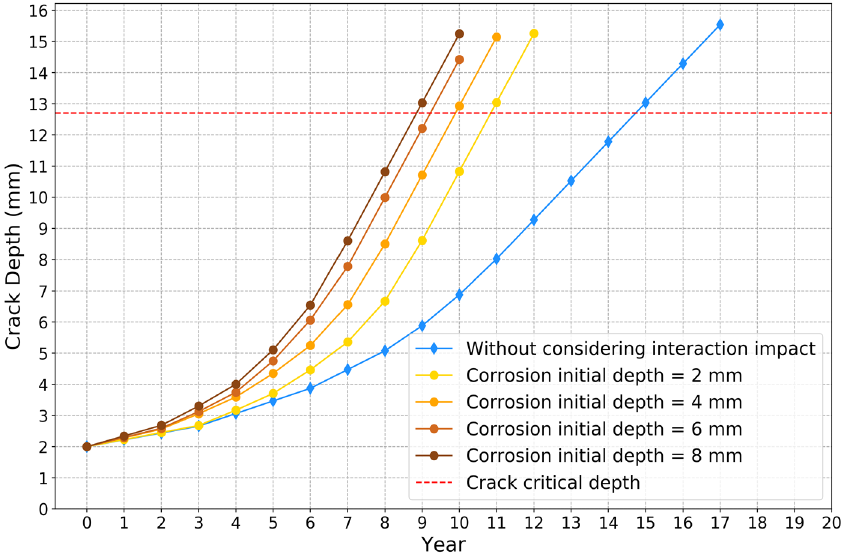
Figure 16. Crack depth growth curves for different corrosion initial depths based on approach 2.